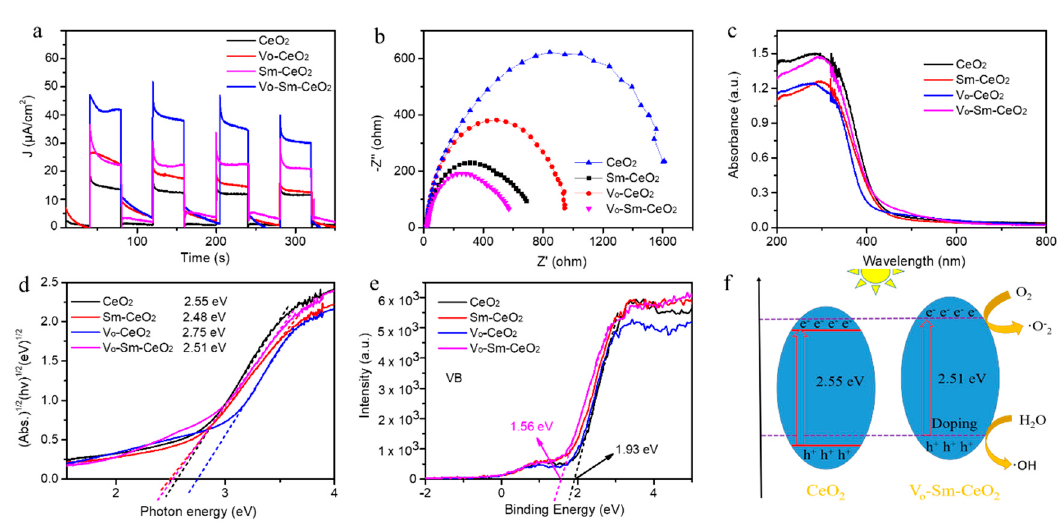
Figure S1: SEM images of CeO 2 , Sm–CeO 2 , Vo–CeO 2 , and Vo–Sm–CeO 2 ; Figure S2: The N 2 adsorption spectra of all samples; Figure S3: Photocatalytic performance of Sm doping CeO 2 ; Figure S4: TOC removal e ffi ciency CeO 2 , Sm–CeO 2 , Vo–CeO 2 , and Vo–Sm–CeO 2 at 120 min; Figure S5: XRD spectra and SEM image of Vo–Sm–CeO 2 after the five cycles test; Table S1: The performance of Vo–Sm–CeO 2 was also compared with other reported Ce based